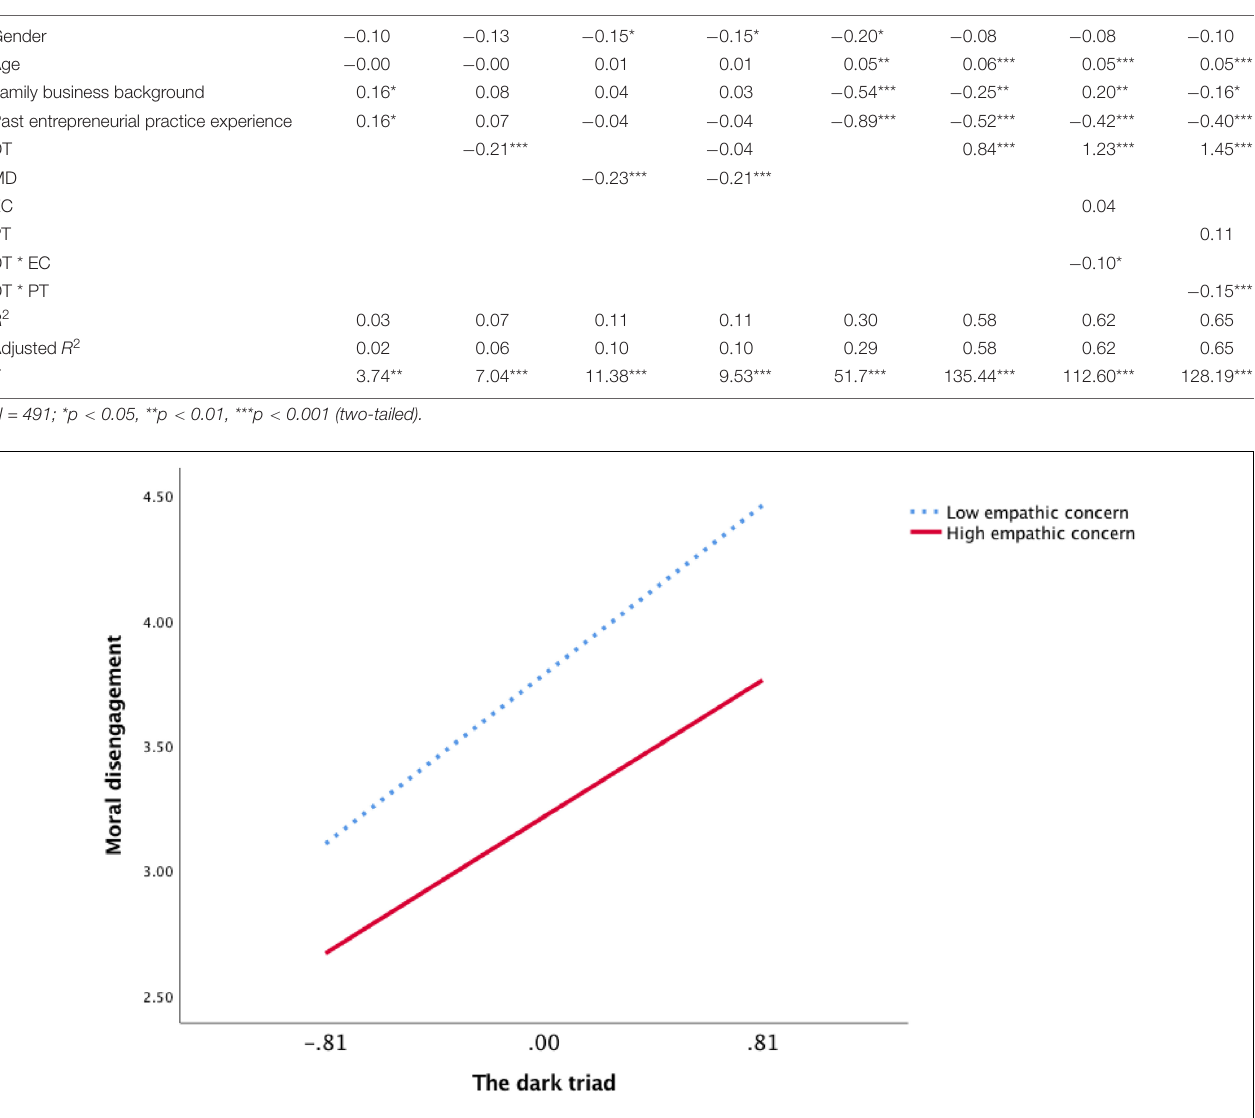
FIGURE 2 | The moderation effect of empathic concern in Study